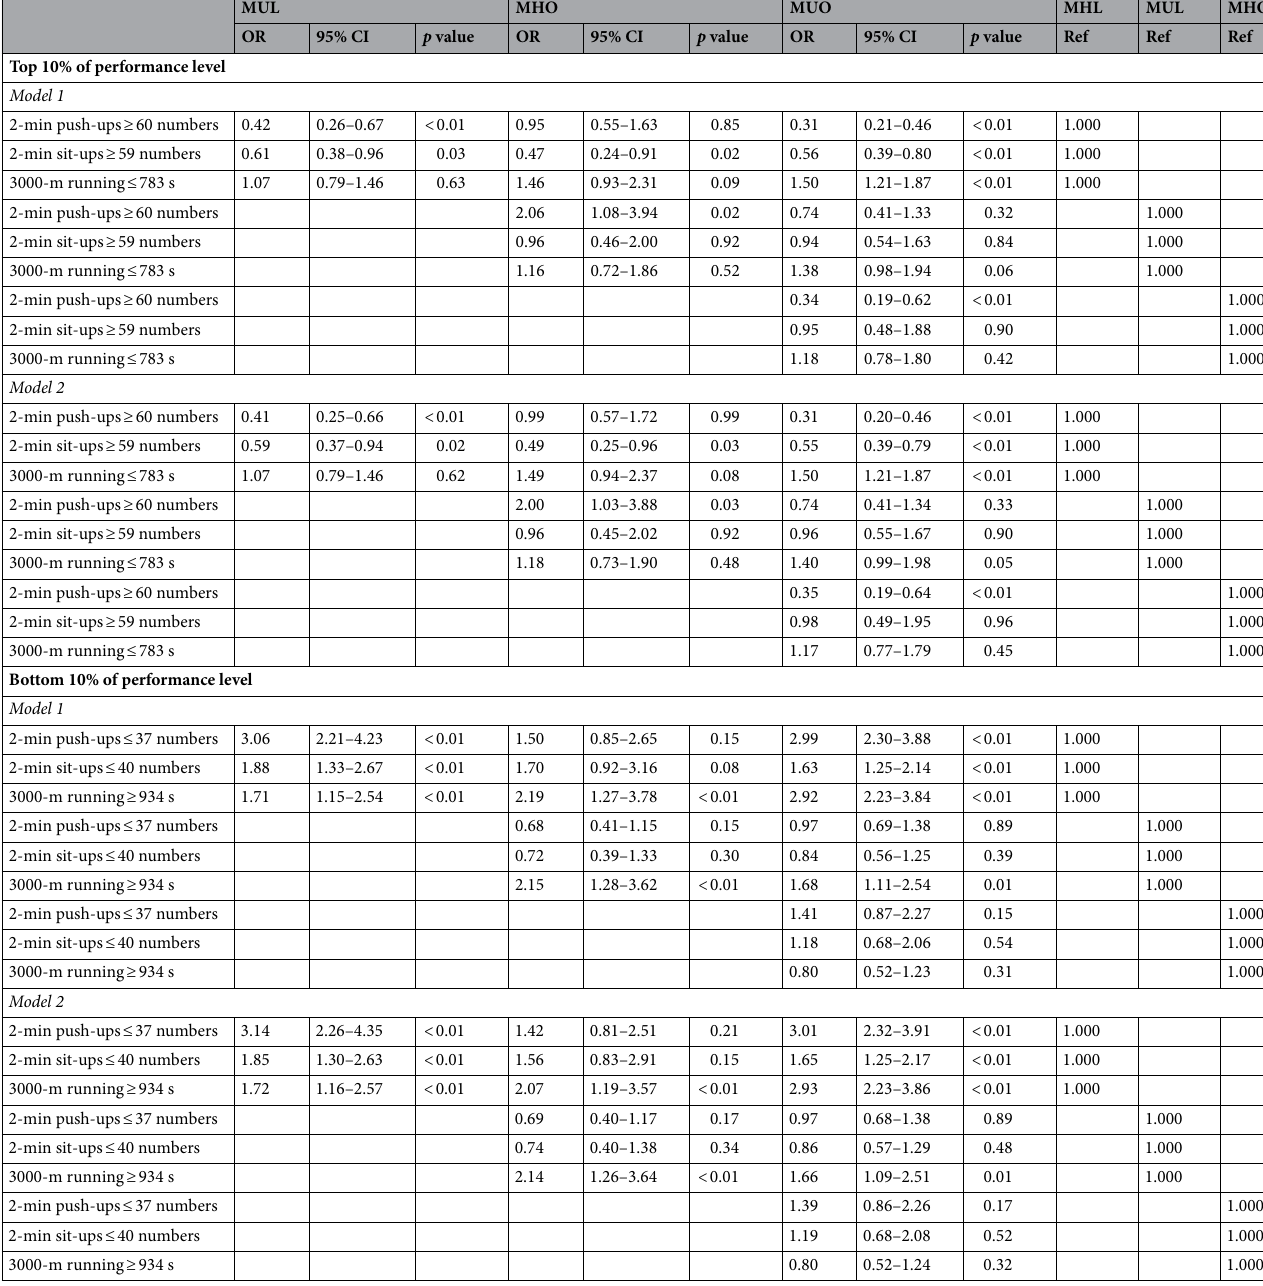
Table 4. Associations of various metabolic and obese groups with the best 10% and the worst 10% of each exercise performance. Data are presented as odds ratios (OR) and 95% CI (confidence intervals) using multiple logistic regression analysis for Model 1: age and service specialty adjustments; Model 2: the covariates in Model 1, physical activity, current alcohol drinking and current smoking adjustments. MHL, metabolically healthy lean; MHO, metabolically healthy obesity; MUL, metabolically unhealthy lean; MUO, metabolically unhealthy